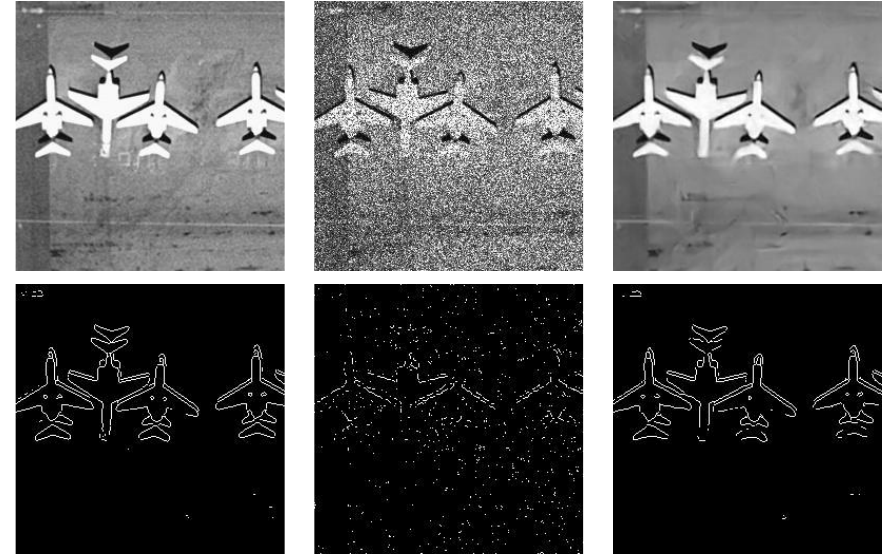
Figure 6. Edge detection results. Images from left to right correspond to a clean image, an image with speckle noise, and image after